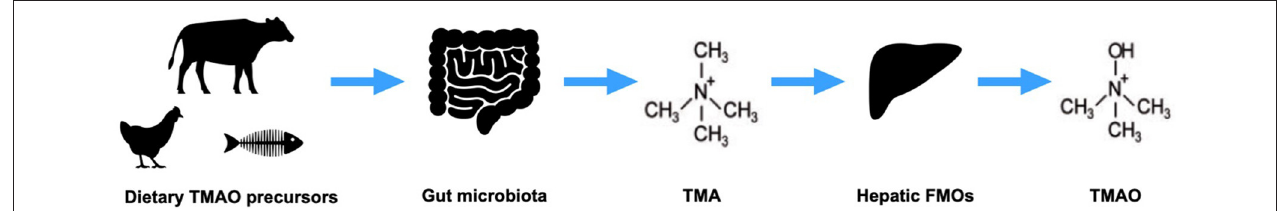
FIGURE 1 | Trimethylamine-N-oxide (TMAO) production. Dietary precursors of TMAO are metabolized by gut microbes to trimethylamine (TMA), which is converted by hepatic flavin monooxygenases (FMOs) to